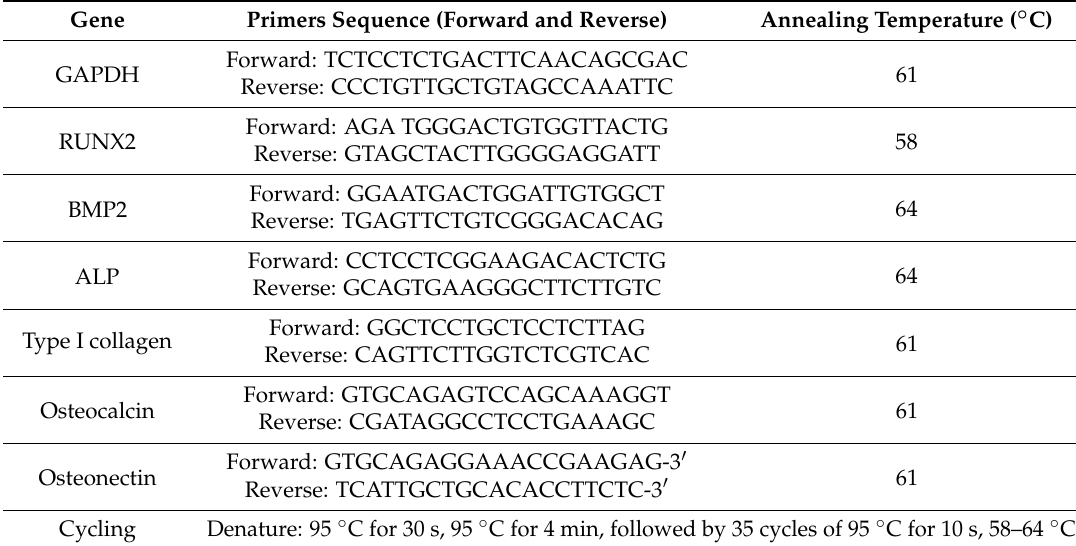
Table 1. Primer sequences and cycling conditions for real-time